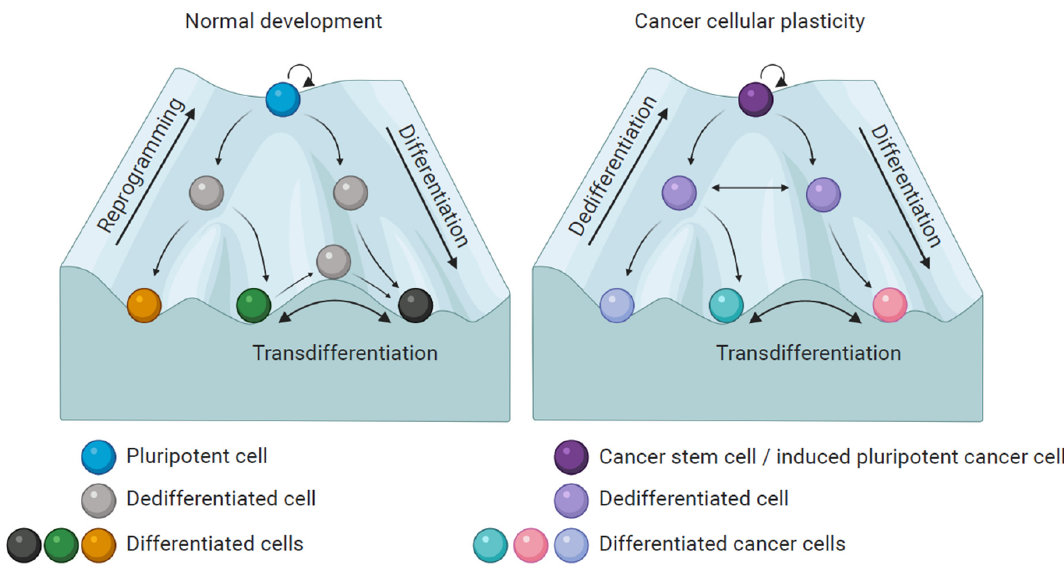
Figure 1. Comparison between normal development and cancer cellular plasticity, based on the model of the epigenetic landscape described by Waddington. Pluripotent cells can differentiate into cells from different lineages. The reverse process from somatic cell to pluripotent cell is known as reprogramming. Additionally, differentiated cells can switch between lineages, a process known as transdifferentiation. In cancer a similar process occurs, in this case, cancer stem cells (CSCs) can generate various differentiated cancer cells and in this way support tumor growth. Moreover, differentiated cancer cells can undergo a reversible dedifferentiation. CSCs, dedifferentiated and differentiated cancer cells together support tumor heterogeneity . Additionally, cancer cells can be artificially converted into induced pluripotent cancer cells by nuclear reprogramming.